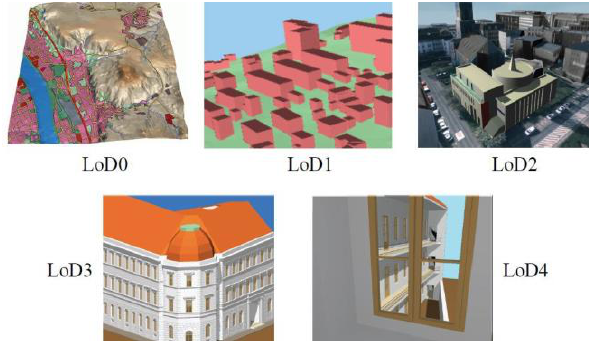
Figure 1. LoD representation defined by CityGML (Kolbe et al., 2005). CityGML proposes 5 different levels of detail LoD for 3D city models as shown in Figure 1 (Kolbe et al., 2005). These detail levels starting from level zero and how detailed the objects in the city model will be displayed are explained below.